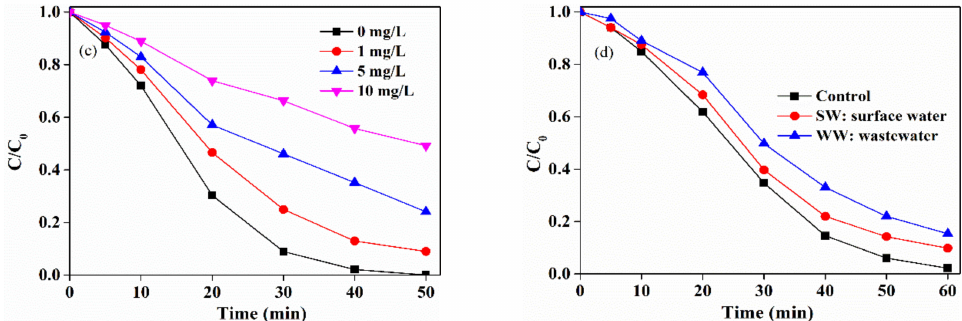
Figure 6. E ff ect of ( a ) Cl - , ( b ) HCO 3 − , ( c ) humic acid and ( d ) real water on the degradation of SMX by